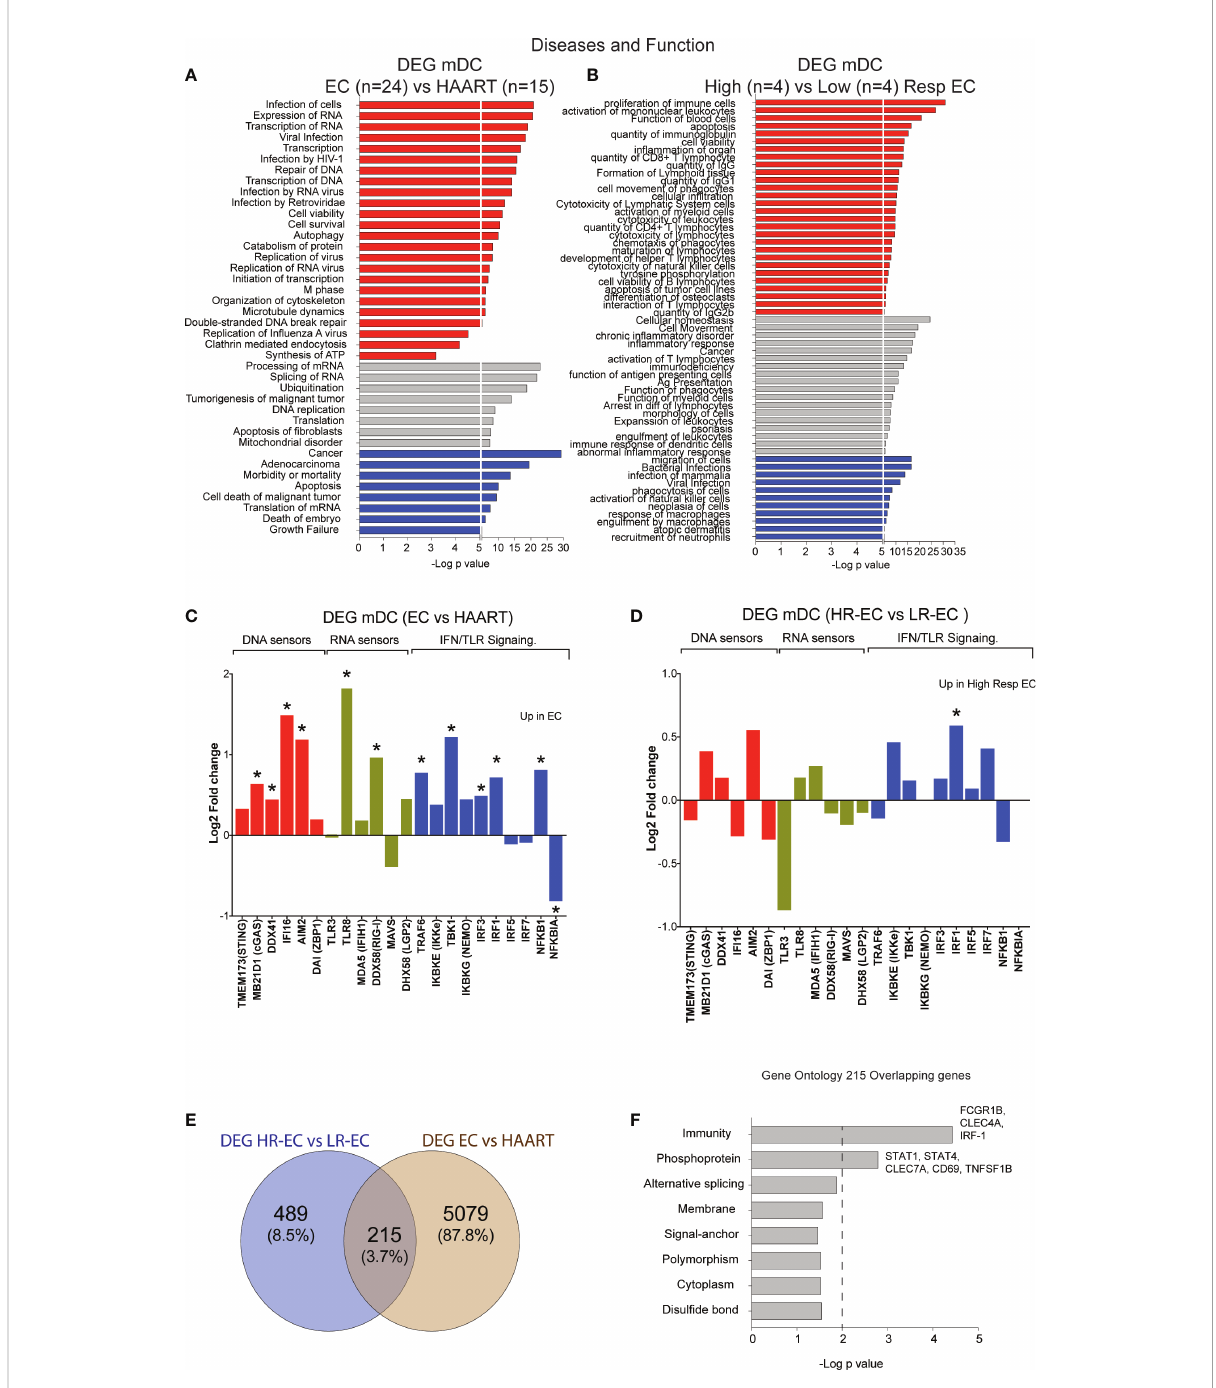
FIGURE 2 Identi fi cation of transcriptional signatures of mDC from total EC and from High vs Low EC responders. (A, B) Ingenuity Pathway Analysis (IPA) for selected diseases and functions for DEG between mDC from total EC (n=24) vs ART-treated individuals (n=15) (A) and High-Responder (HR, n=4) vs Low-Responder (LR, n=4) EC subgroups (B) . Pathways predicted to be upregulated (red), downregulated (blue) or with non-directional predictions (grey) are highlighted. (C, D) Log2 Fold change in expression of selected DNA sensors, RNA sensors and IFN pathway elements included in the list of DEG for EC vs HAART-treated individuals (C) and for HR vs LR EC (D) . Statistically signi fi cant (FDR-adjusted p<0.05 EC vs HAART; nominal p<0.05 HR-EC vs LR-EC) DEGs are highlighted with a star. (E) Venn diagram representing overlap between DEG from total EC vs HAART participants and DEG from HR-EC vs LR-EC subgroups. (F) Biological pathways enriched within the 215 overlapping genes de fi ned in (E) , as determined by DAVID gene ontology analysis. *p <